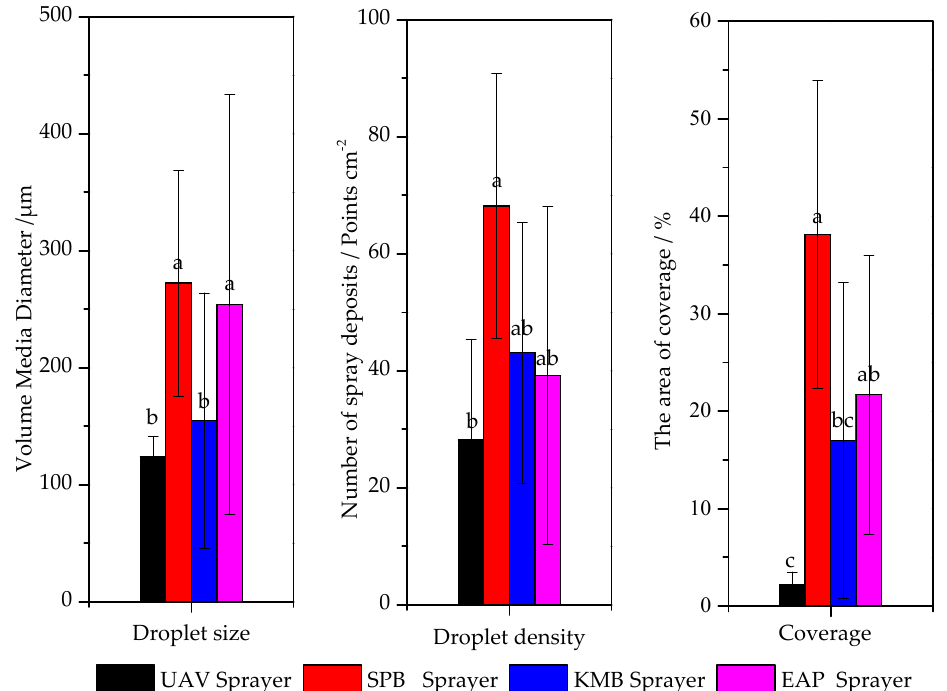
Figure 5. Characterization of the deposition including droplet size, number of spray deposits and the area of coverage.